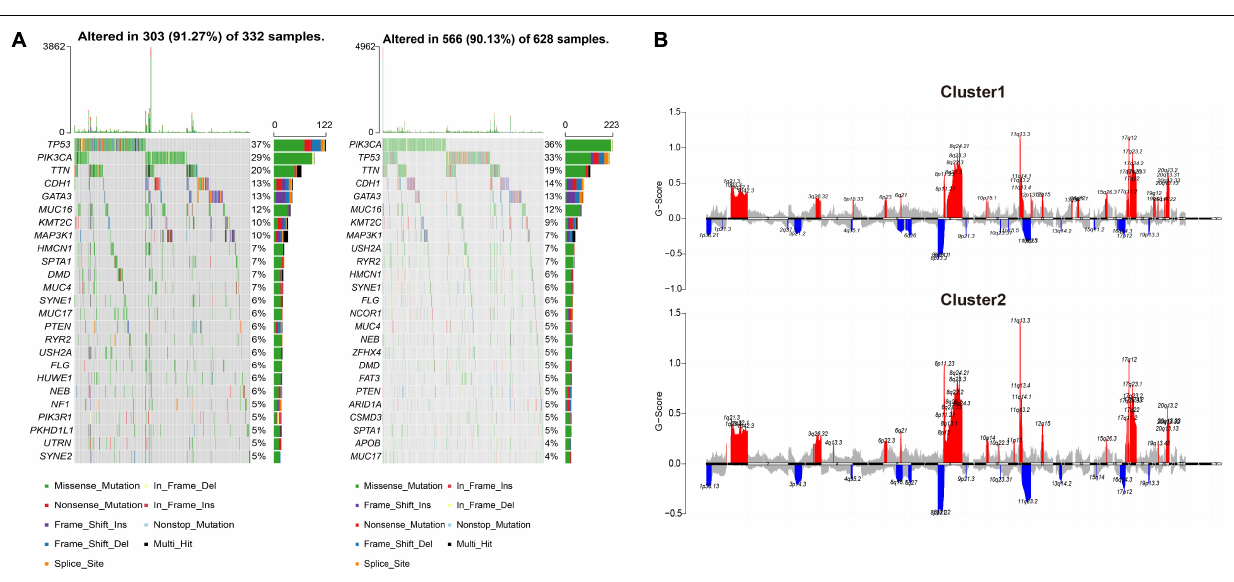
FIGURE 2 | The differences in CNV and copy number variation between the two subgroups. (A) The oncoprint plots indicate the top 25 mutated genes in both cluster 1 and cluster 2 samples. Different colors stand for different mutation types. (B) Cumulative CNV regions for cluster 1 and cluster 2. Deletions are represented in blue color, and amplifications are represented in red